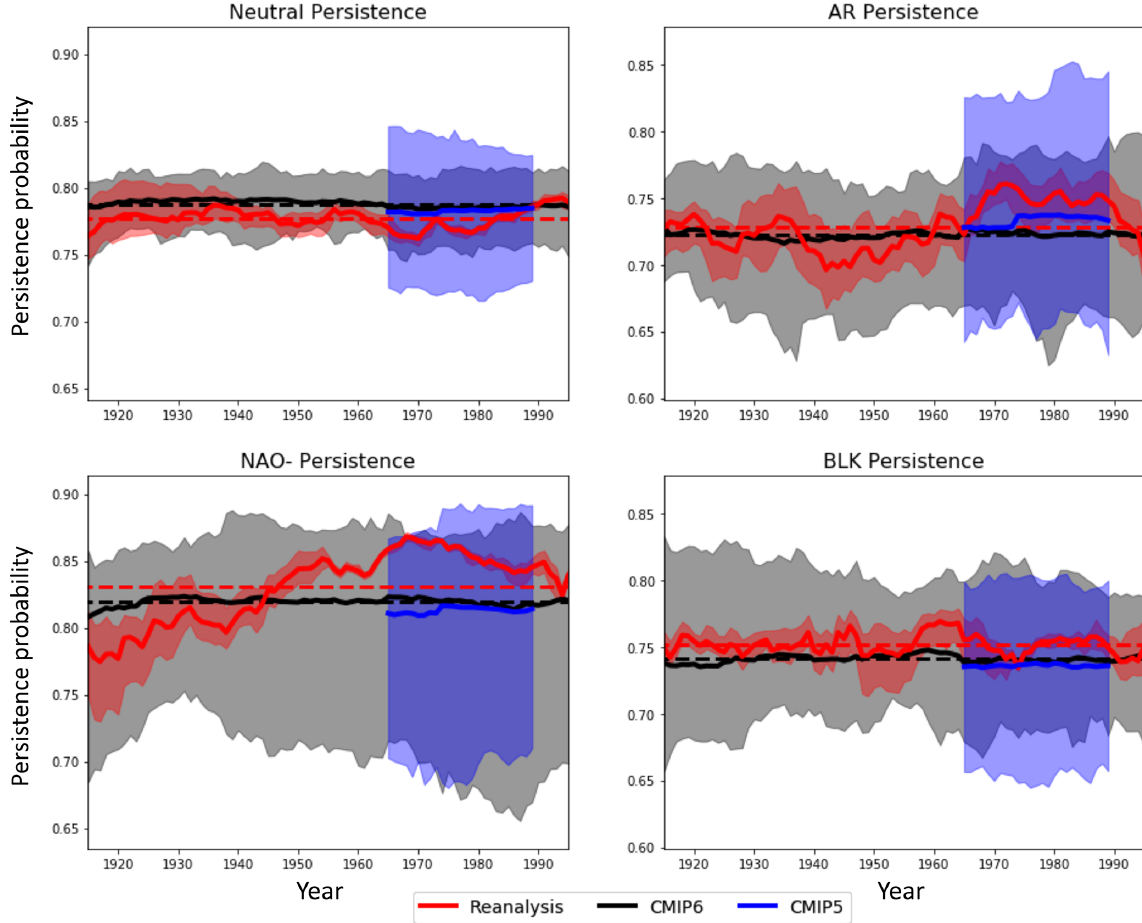
Figure 11. As in Fig. 10 but showing regime